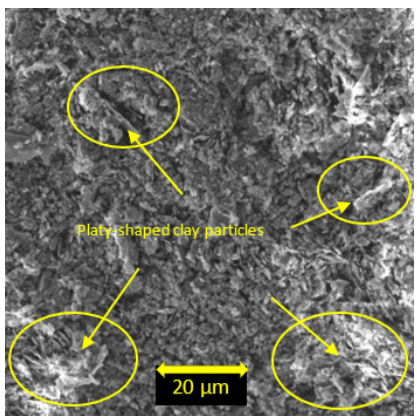
Figure 2. Scanning Electron Microscopy (SEM) image of the soil.